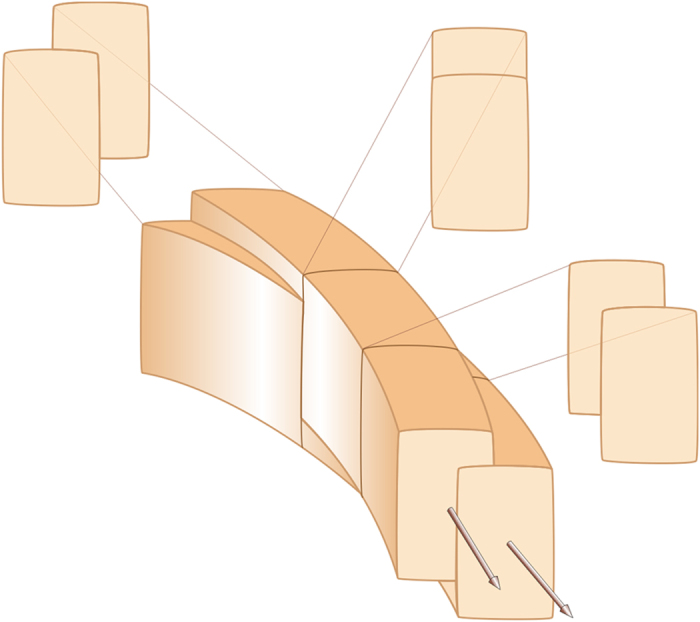
Interlocking mechanism between fibres.Two non-coaxial spiral fibres interlock progressively in the way shown above. Both fibres grow towards the reader and towards the bottom (arrows). The lower fibre crosses the upper fibre (the one running ahead) from left to right. During the process, the cross-sectional outline of the upper fibre changes progressively in the way depicted.